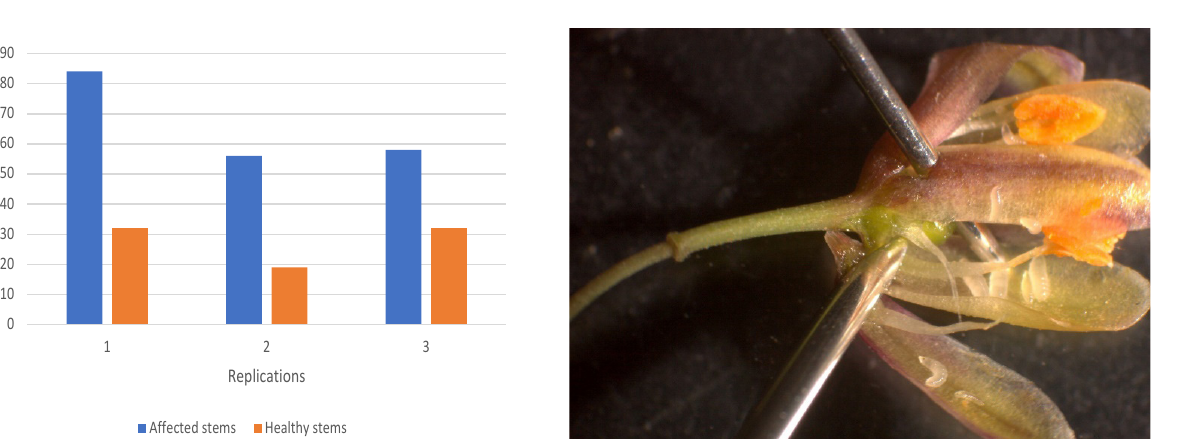
Figure 11. Number of larvae in male asparagus flowers